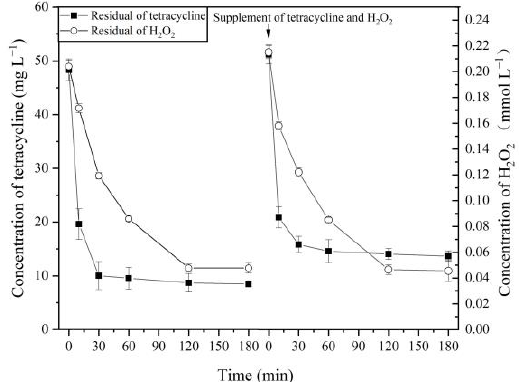
Figure 2. Effect of H 2 O 2 and TC supplementation on degradation of TC by the MnP system.